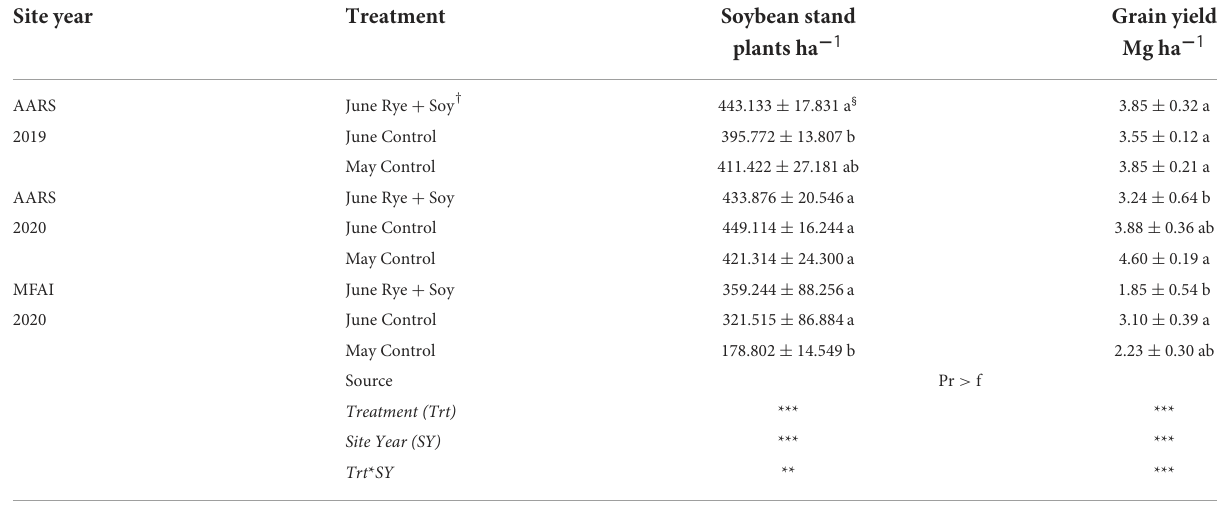
TABLE 3 Analysis of variance and mean soybean stand counts and soybean grain yield, shown with standard deviation, at the Arlington Agricultural Research Station (AARS), Arlington, WI and Michael Fields Agricultural Institute (MFAI), East Troy, WI, 2019–2020.